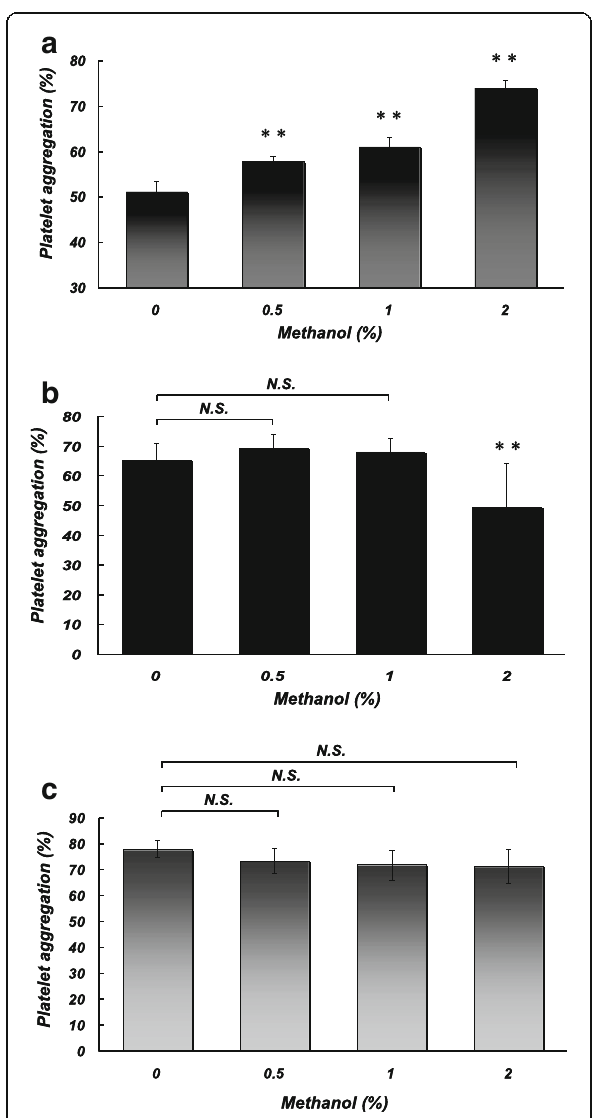
Fig. 3 Effects of pretreatment with different concentrations (0, 0.5, 1, and 2%) of methanol on Ca 2+ entry induced by extracellular addition of CaCl 2 (0.5 mM) in the presence of thrombin (0.025 U/ml) ( a ), thapsigargin (1 μ M) ( b ), or OAG (100 μ M) ( c ). N.S. no significant difference. N = 6 –